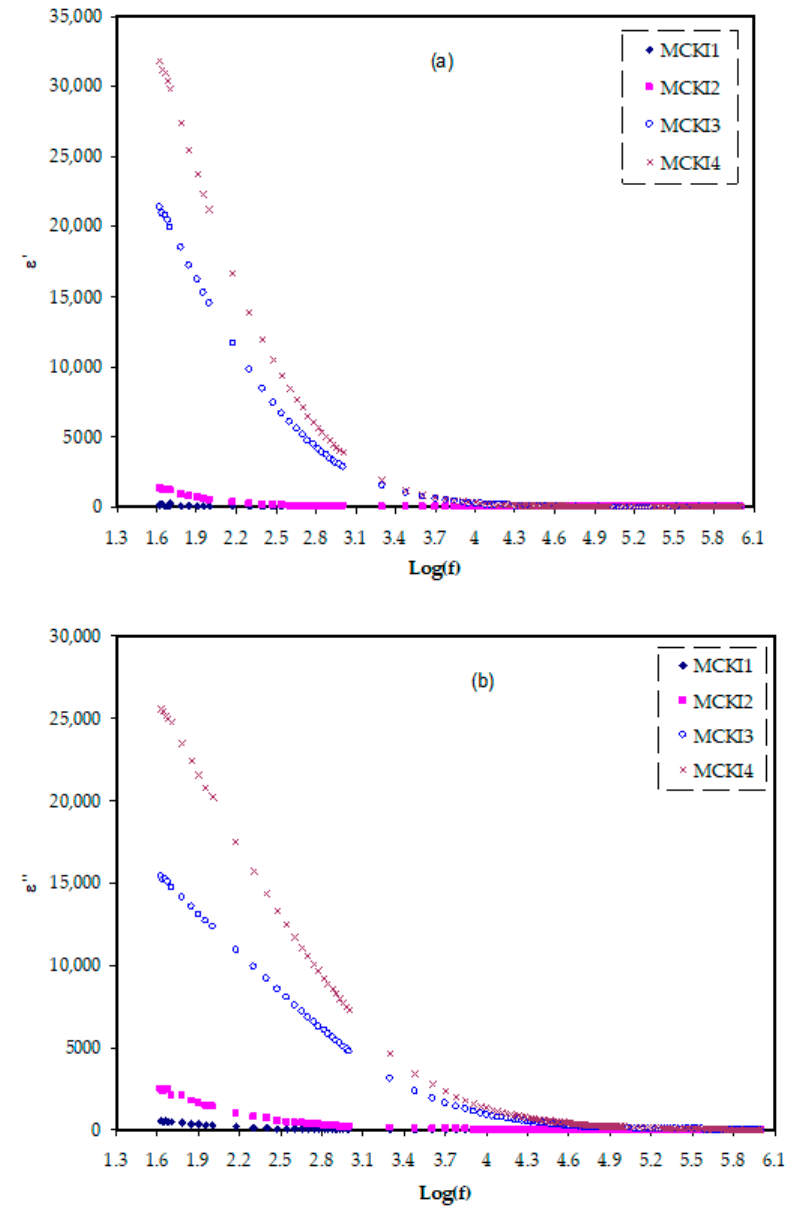
Figure 4. Dielectric plot for ( a ) ε′ and ( b ) ε″ variation against frequency for the MCKI samples. The Z r and Z i data were achieved from the EIS data and then used to determine the ɛ ′ and ɛ ″ data. The ɛ ′ and ɛ ″ were used to find the tan δ . The tan δ is the ratio between factor [23] and it is determined using Equation (16).